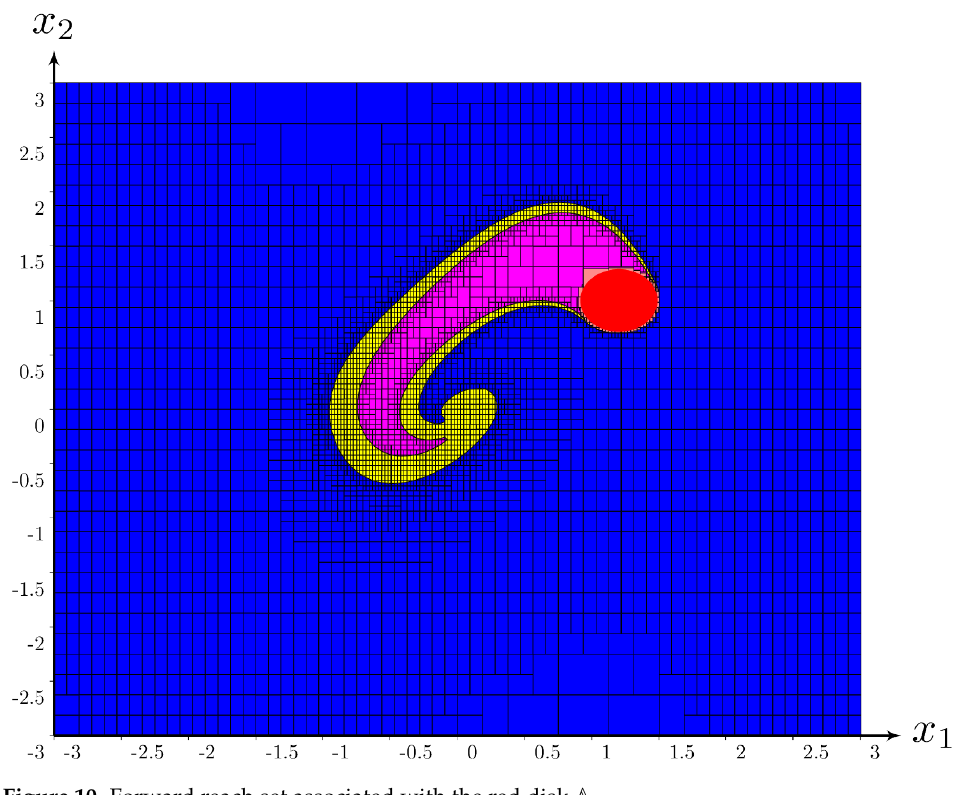
Figure 10. Forward reach set associated with the red disk A